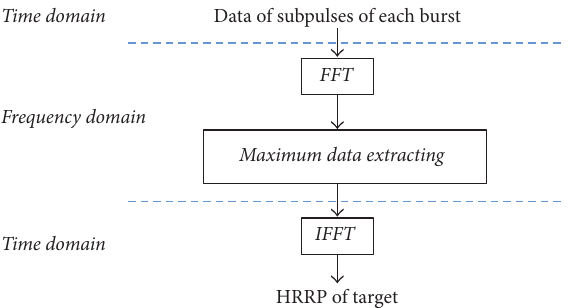
Figure 3: Basic idea and flowchart of the FDEM to obtain